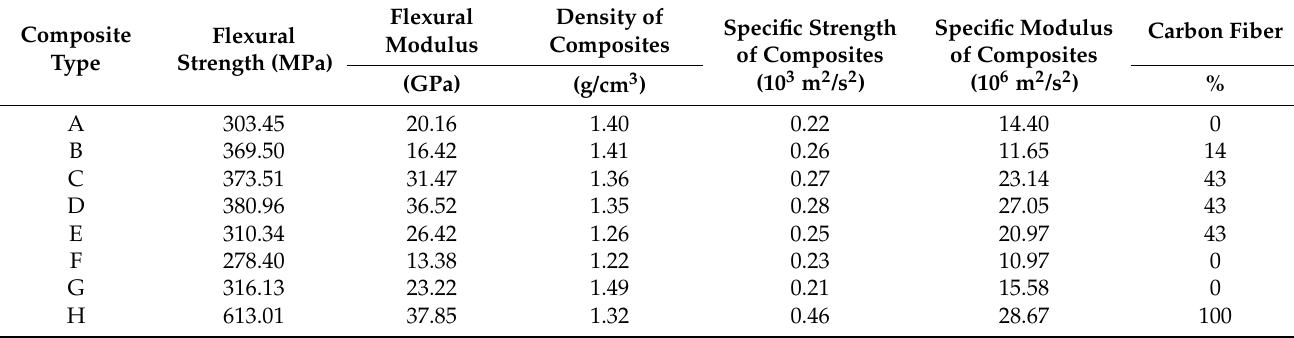
Table 2. Specific flexural strength and modulus of composites .